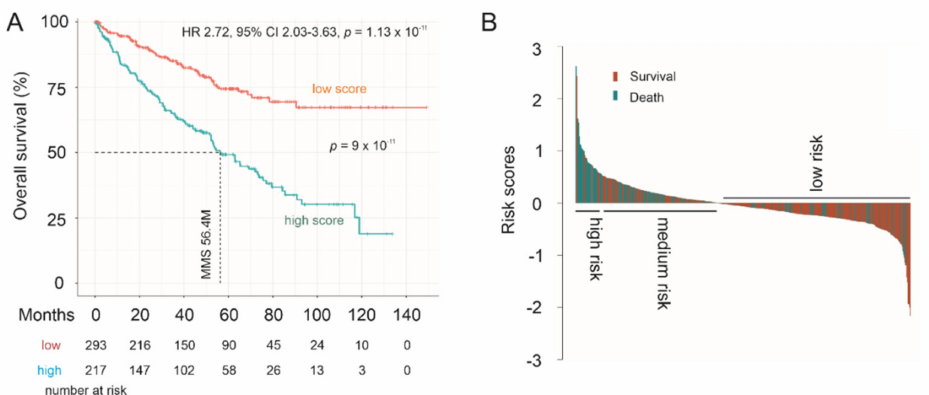
Figure 11. Prediction of poor Overall Survival (OS) of clear cell renal cell carcinoma (ccRCC) using the LE multigene panel. ( A ) Kaplan–Meier survival curves. Statistical analyses were performed using log rank test. ( B ) Waterfall plot of risk